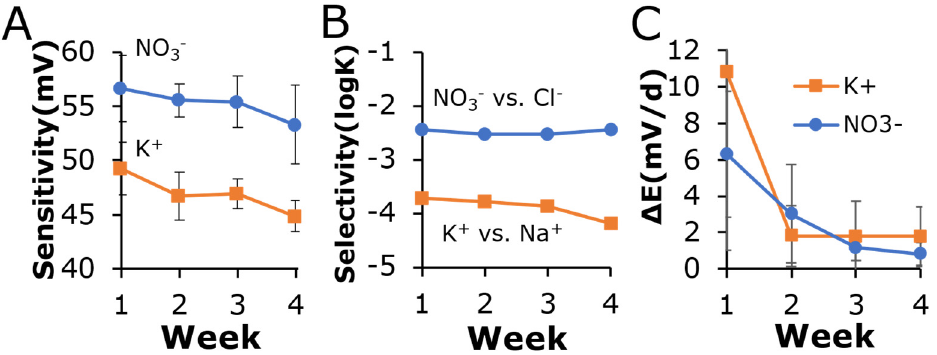
Figure 5. Long-term sensor performance: ( A ) Sensitivity of ISEs. The sensitivities were measured by two-point calibration between 1 and 10 mM KNO 3 . ( B ) Selectivity of ISEs. For K + electrodes, selectivity was measured against Na + ions; for NO 3 − electrodes, selectivity was against Cl − ions. ( C ). Baseline drift of ISEs at 1 mM KNO 3 (in mV per day, mV/d) over a 4-week period. Reference: electroplated Ag/AgCl. For all measurements, 10 mM NaCl was added as background. At least 3 electrodes were used for each measurement. Sensors were stored dry in air between measurements.